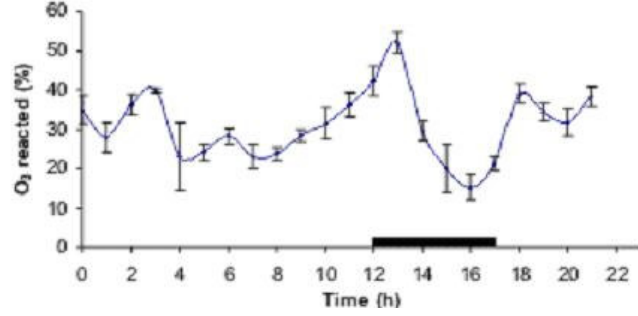
FIGURE 3. Ozone reacted (%), 24-h profile. Vertical bars indicate ± SE. Horizontal thick bar indicates the period of maximum values of ozone. Time is set from 0 to 23 h. n =